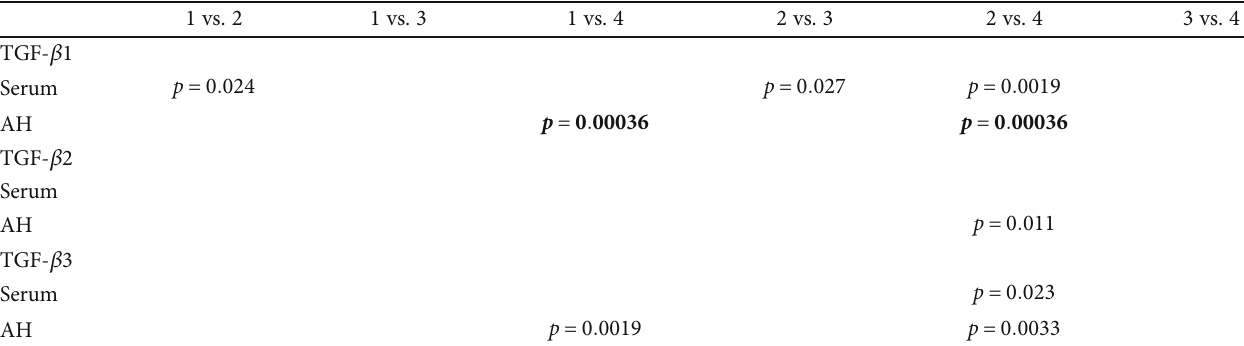
Table 3: Comparison of concentrations of TGF- β 1, TGF- β 2, and TGF- β 3 in serum and AH of healthy individuals (controls) and diabetic patients with di ff erent stages of DR.